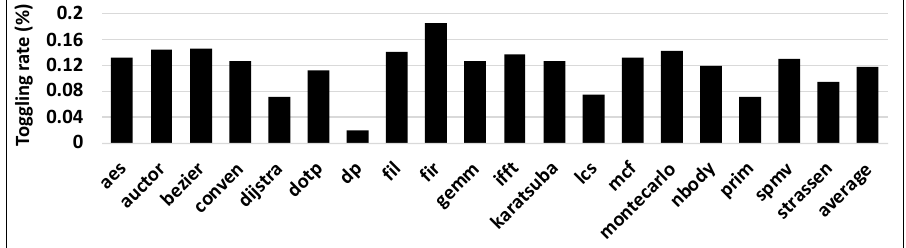
Figure 6. The average toggling rate of 4x4 CGRA running over 19 applications.